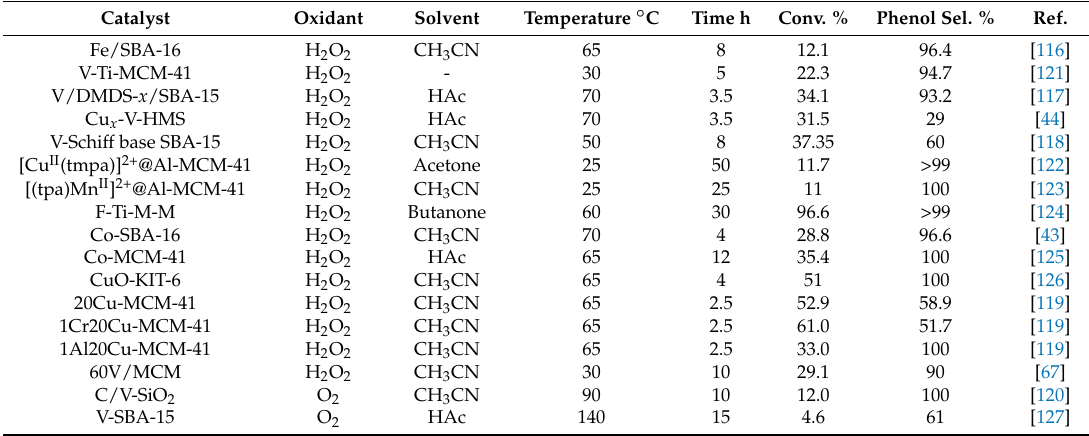
Table 1. Catalytic properties of different catalysts on benzene